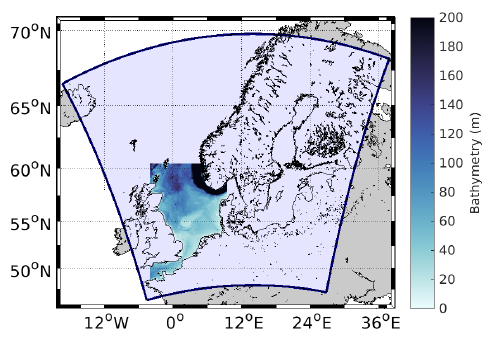
Figure 1. Bathymetry of the wave model WAM (shaded) and area of the atmospheric model CCLM